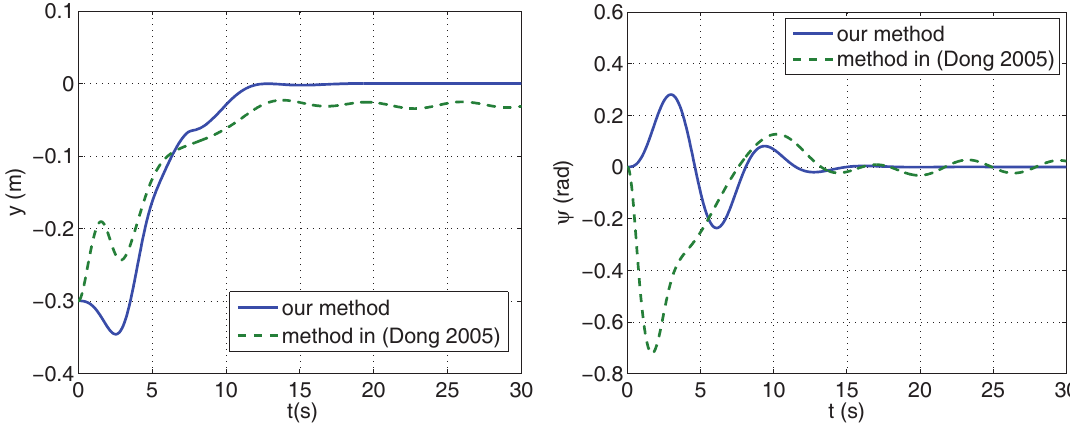
Figure 4. Comparison of the y -coordinate position and heading angel ψ of this paper and [12].